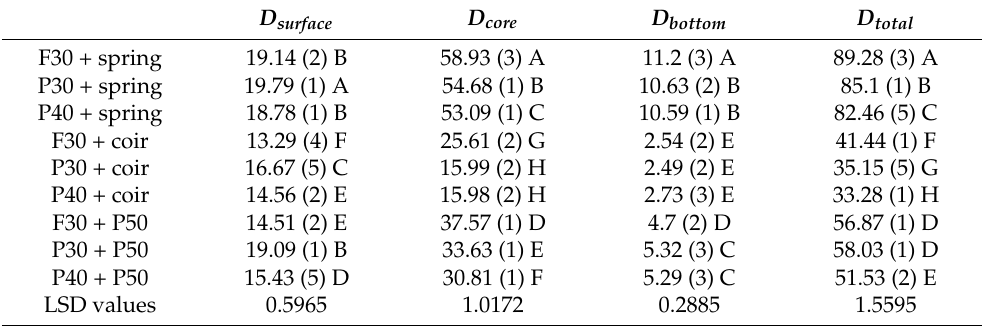
Table 3. Mean layered hardness of the mattresses evaluated in this study.